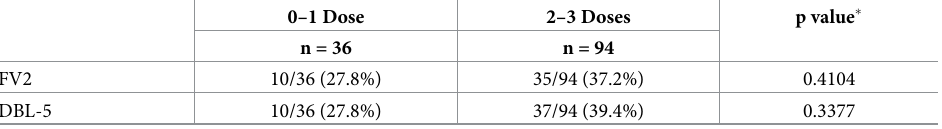
Table 3. Percentage of women with antibodies to VAR2CSA (FV2 and DBL5 FCR3) at delivery by use of